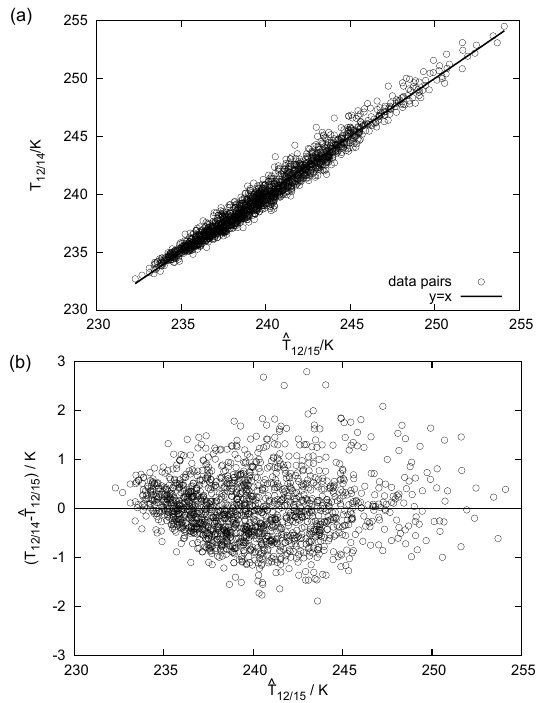
Figure 6. (a) Scatter plot showing a linear correlation between a linear superposition of channel 11 and 12 brightness temperatures from NOAA 15 (abscissa, ˆ T 12 / 15 ) with the corresponding channel 12 brightness temperature for the same profile but computed with the NOAA 14 channel response function. Note that the fit line has slope 1.000 and the intercept is close to zero (2 × 10 − 4 ). The lin- ear correlation is R = 0 . 986. All data are computed using the Lin- denberg profiles. (b) The same data, plotted with the difference in T 12 / 14 − ˆ T 12 / 15 on the y axis.